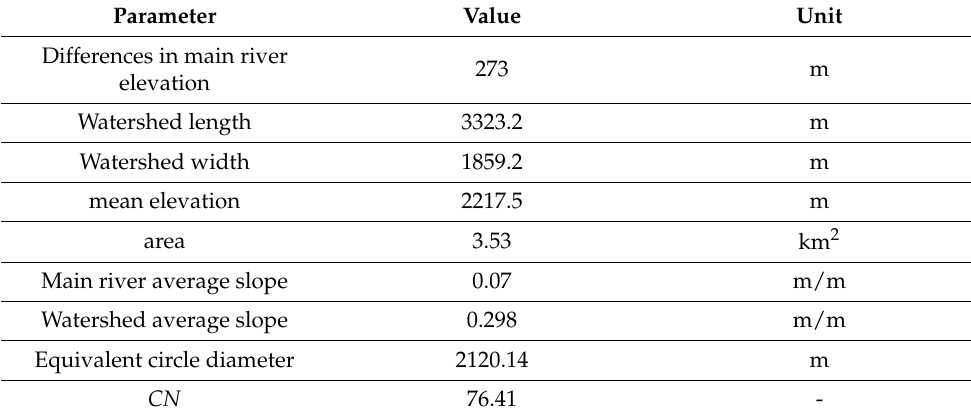
Table 1. Physical parameters of Aliabad